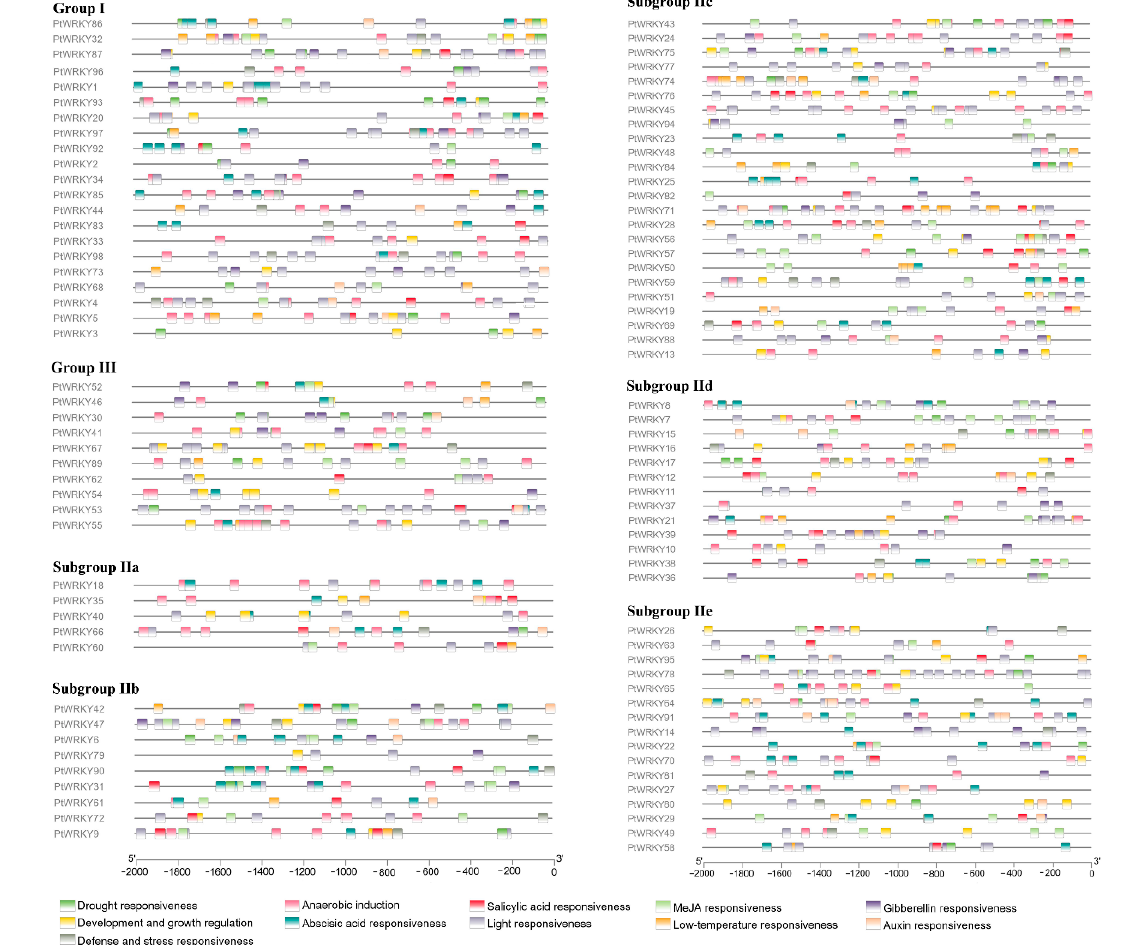
Figure 4. Cis-acting elements in PtWRKYs promoter. Line represents 2000 bp gene upstream sequence, and different color rectangles represent different response elements.